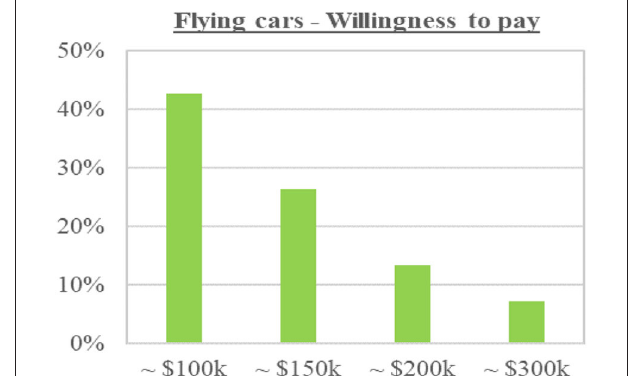
FIGURE 4 | Willingness to pay.